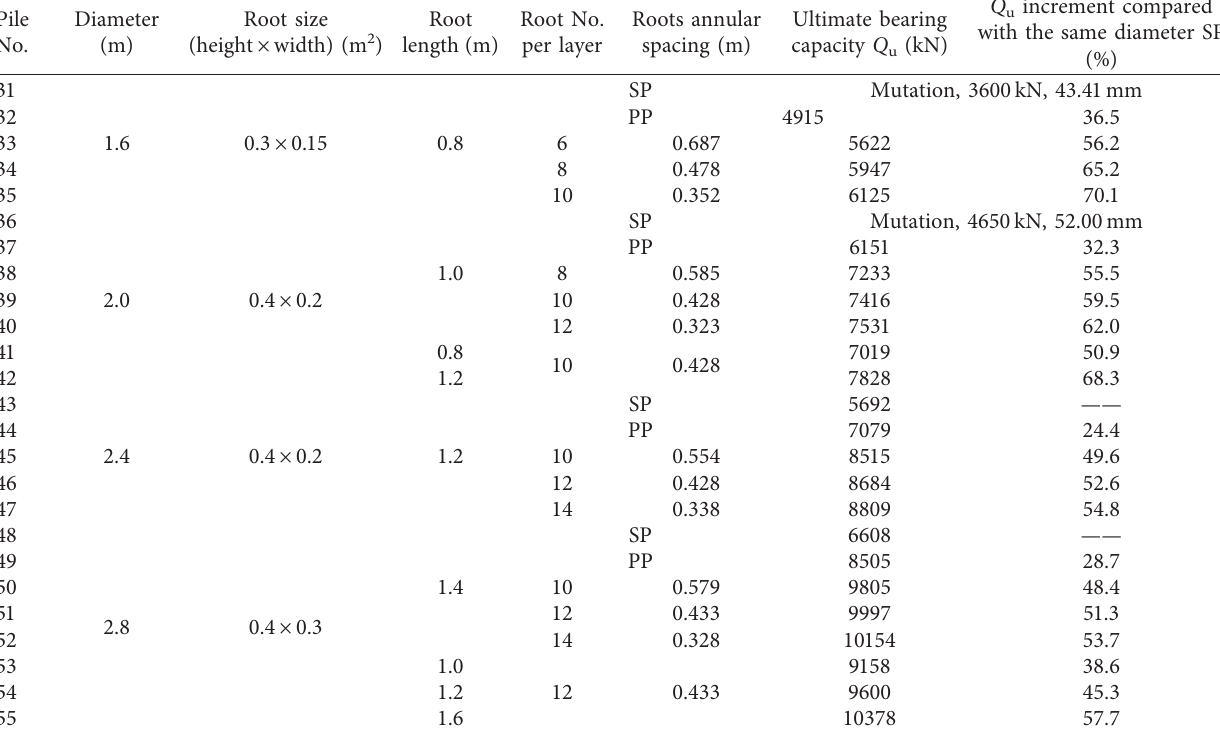
Table 4: Simulation programs and results of piles with different diameter.